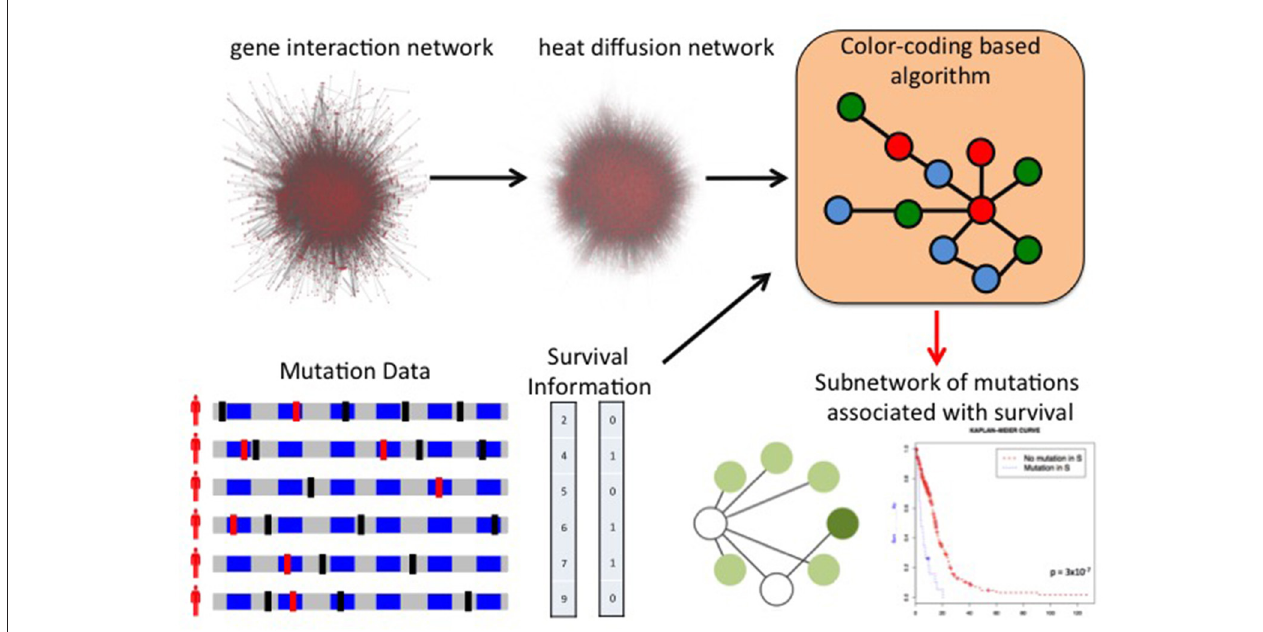
FIGURE 5 | Network of Mutations Associated with Survival (NoMAS). NoMAS combines mutations measured in many patients and the corresponding survival time with a large interaction network to identify subnetworks of genes with significant association to survival. NoMAS is based on an efficient graph color-coding algorithm, and uses a permutation test to correct for multiple hypothesis